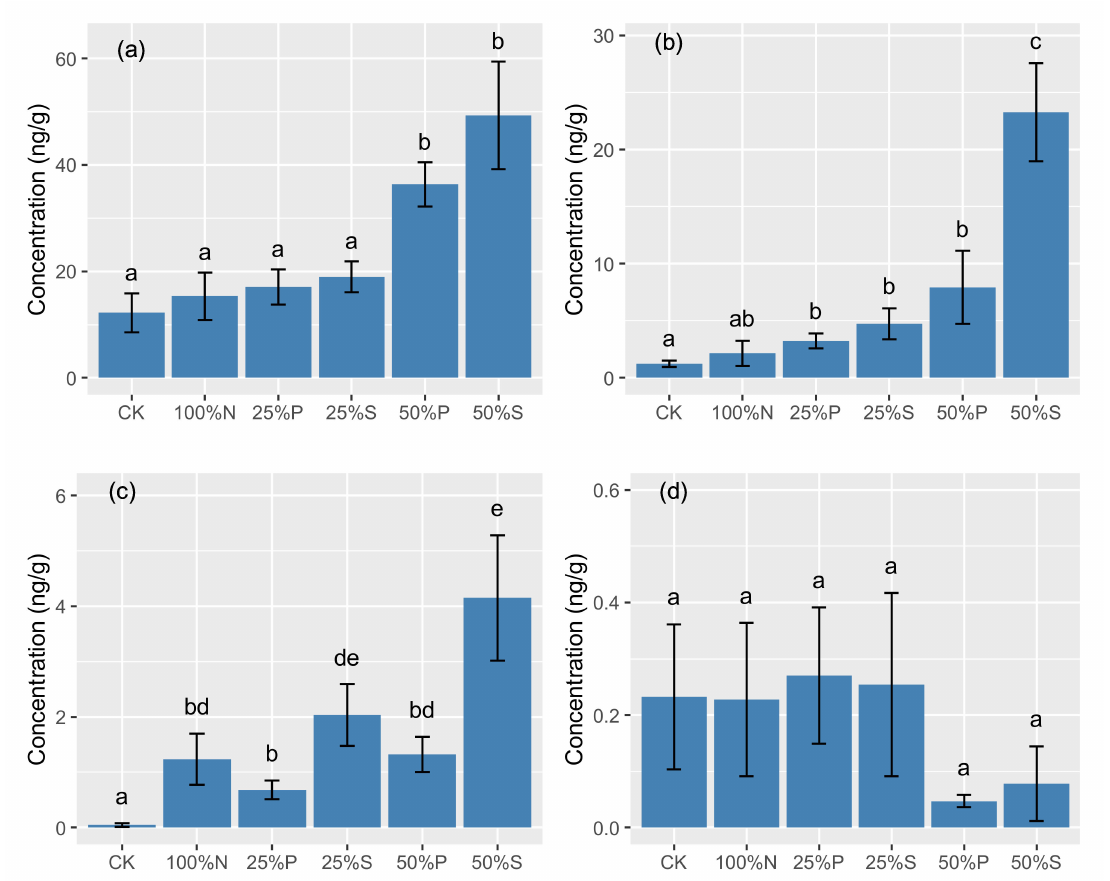
Figure 1. Antibiotics in soil from different treatments. ( a ) Tetracyclines, ( b ) quinolones, ( c ) sulfonamides, and ( d ) macrolides. Error bars depict standard deviations of the means. The different letters indicate significant differences among the treatments ( p <